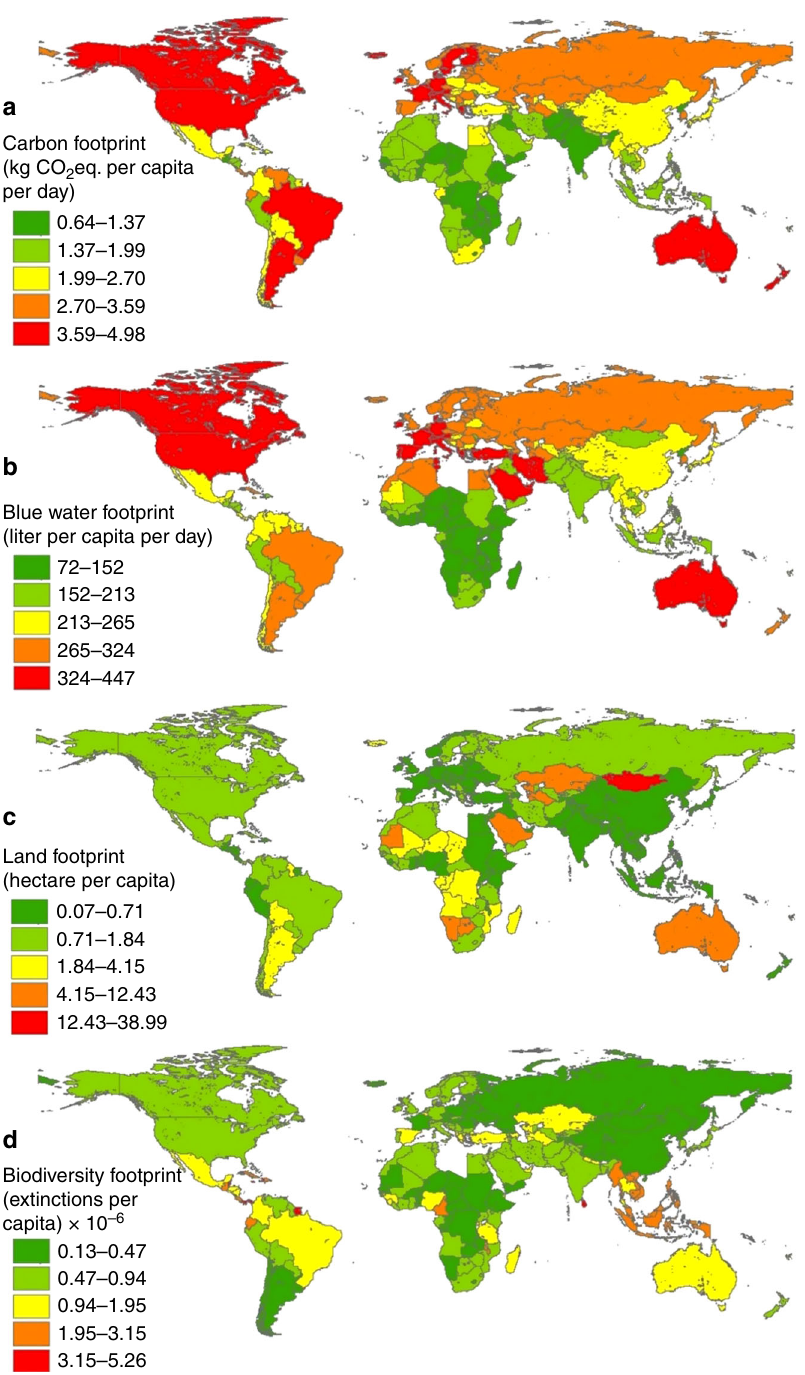
Fig. 2 Per capita food related environmental footprints of 156 countries. a Carbon, b Blue water, c Land, and d Biodiversity footprint of daily average diets of each country in the year 2011. Symbology based on Jenks natural breaks classi fi cation method. See Supplementary Data 1 for normalized (0 – 100) score of